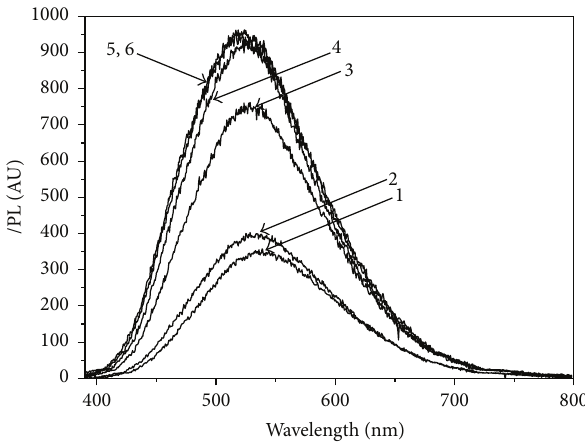
Figure 10: The luminescence spectra of the colloidal solutions of ZnO nanoparticles without SiO 2 (1) and with provisionally adding 0.2 g (2), 0.4 g (3), 0.6 g (4), 0.8g (5), and 1g of silica (6) to 10mL of zinc oxide solution. [ZnO] = 2 × 10 −2 mol/L, 𝑙 = 0.1 cm, and 𝜆 340 nm.